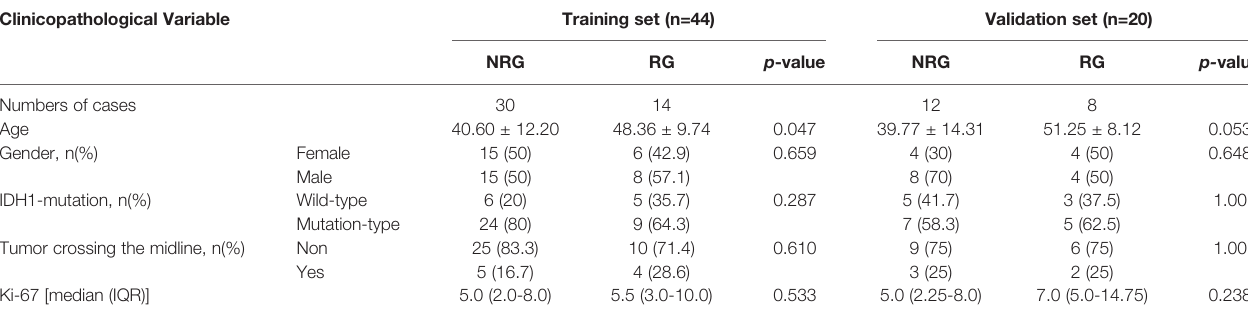
TABLE 2 | Baseline demographics and clinical characteristics of patients in the training and validation datasets. Clinicopathological Variable